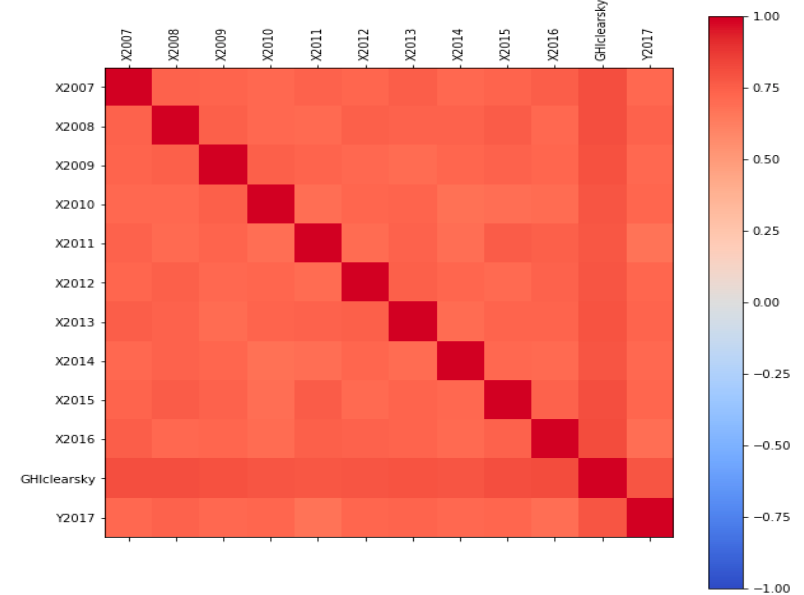
Figure 4. Correlation between observed GHI (Y) vs. historical data (X) and clear sky GHI.